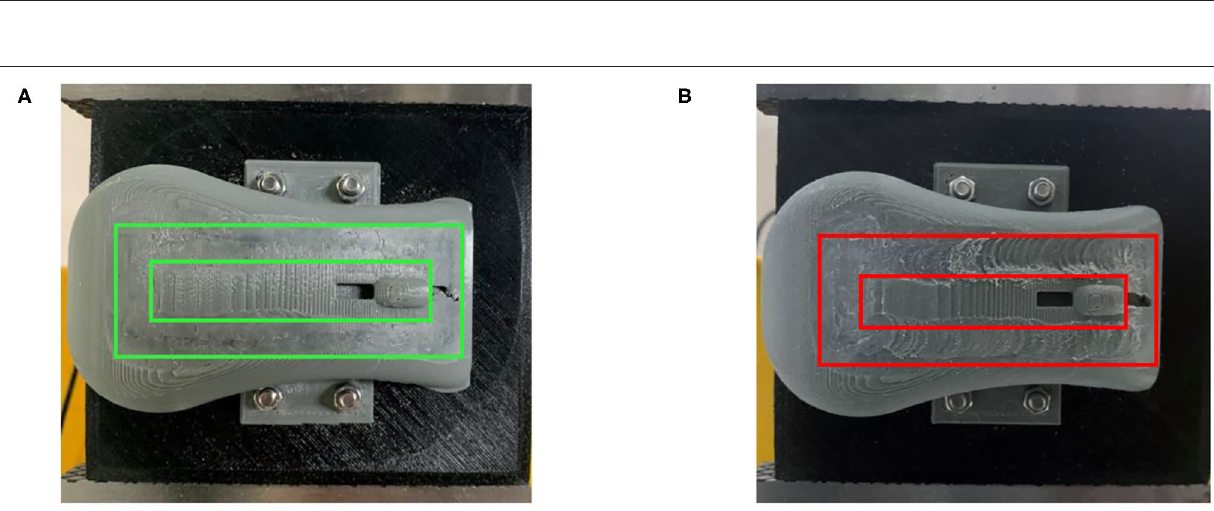
FIGURE 8 | (A) Grinding effect based on the compliant grinding framework. (B) Grinding effect of the comparative